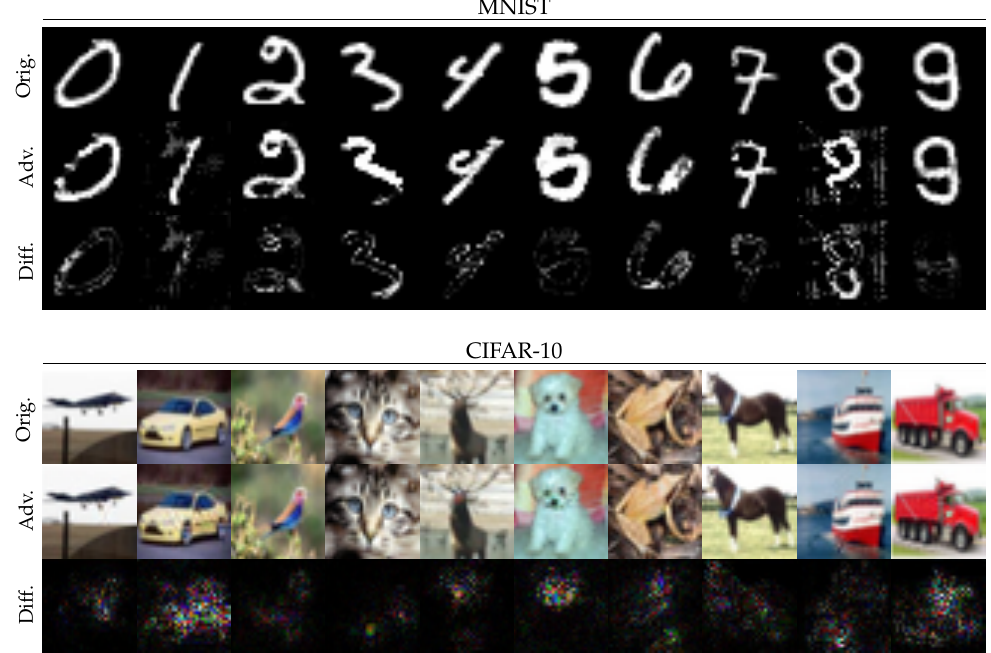
Figure 2. Adversarial examples found with the Carlini and Wagner attack on our neural ODE network on MNIST and CIFAR-10 datasets. Adversarial perturbations (Diff.) of CIFAR-10 samples have been amplified by a factor 10 for visualization